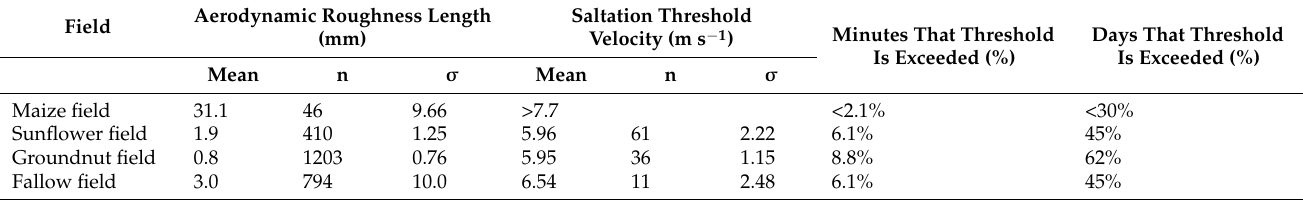
Table 3. Measured average aerodynamic roughness length and saltation threshold velocity of the different fields.